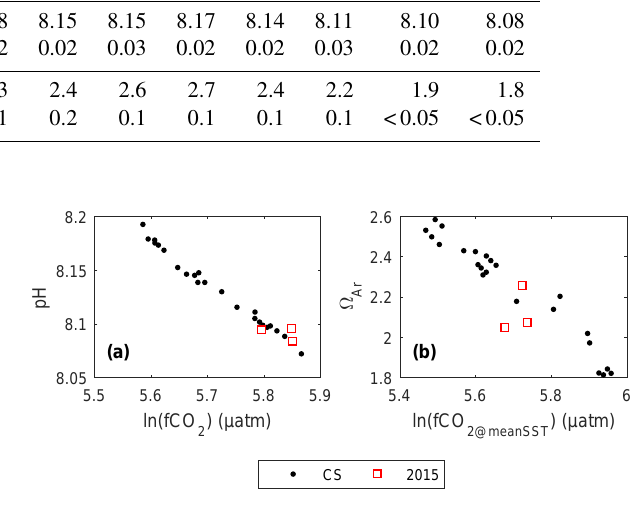
Figure 5. (a) and (b) pH and (cid:127) Ar from CS (dots) and 2015 (red squares) cruises plotted as a function of ln( f CO 2 ) and ln( f CO 2meanSST ) ,